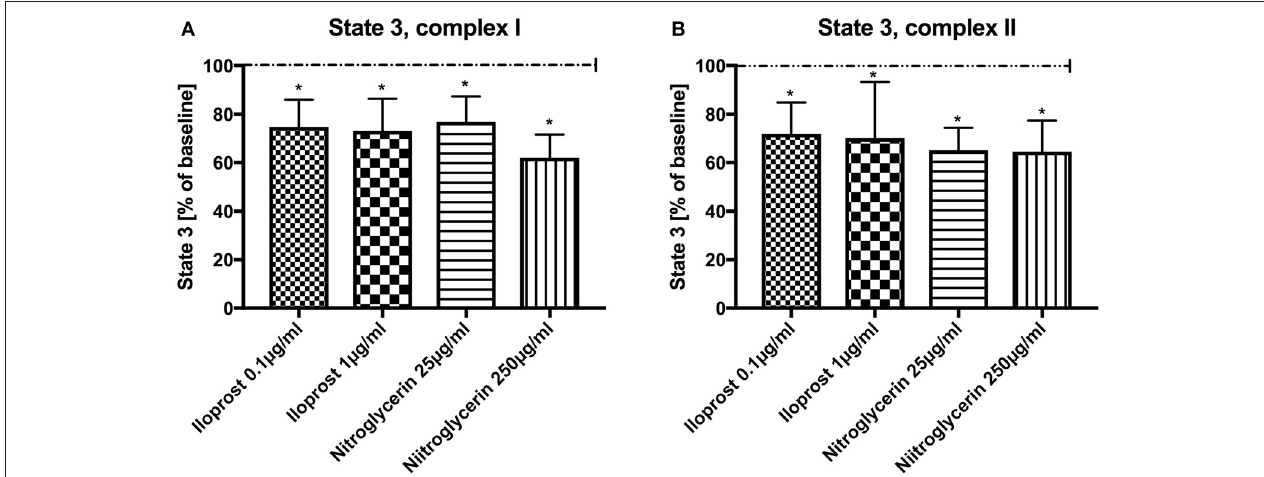
FIGURE 1 | Effect of iloprost (0.1 µ g/ml and 1 µ g/ml) and nitroglycerin (25 µ g/ml and 250 µ g/ml) on maximal mitochondrial respiration (State 3) after stimulation through complex I (A) and II (B) shown as percentage of the baseline value (determined before incubation with iloprost/nitroglycerin). Data are shown as mean ± SD, * p < 0.05 vs. control, n =